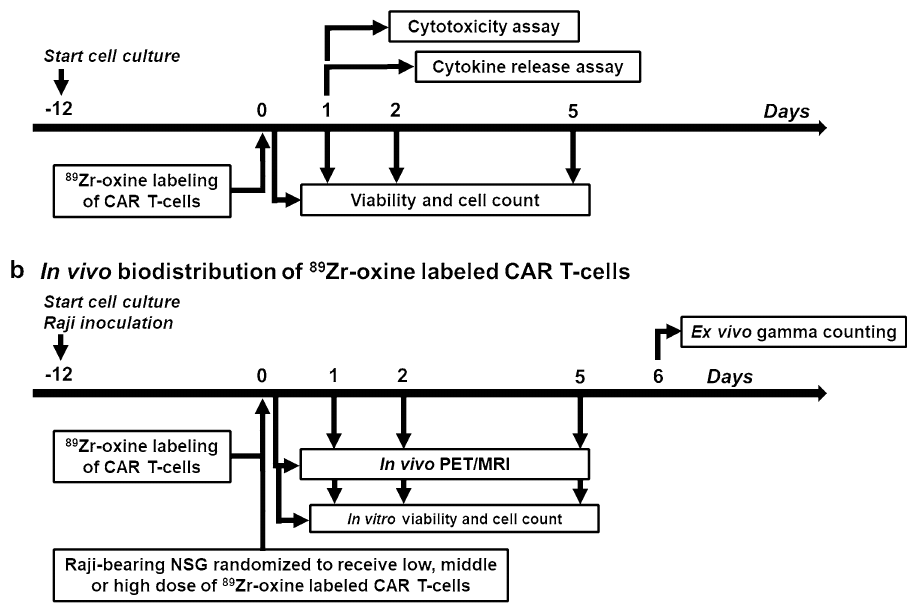
Figure 1. Study timelines. ( a ) In vitro measurements of cell health and function of 89 Zr labeled and unlabeled non-transduced (mock) T-cells and CAR T-cells were obtained in a separate experimental trial. Percent lysis of target Raji cells (cytotoxicity) and released cytokine levels in situ by the effector 89 Zr-oxine labeled and unlabeled mock and CAR T-cells were measured 24 h after incubation of the effector cells with the target cells. Incubation of effector and target cells began 3 h post 89 Zr-oxine labeling. Aliquots of 89 Zr-oxine labeled and unlabeled mock and CAR T-cells were subcultured for in vitro viability and live cell number counts on the same in vivo scan timepoints. ( b ) In vivo biodistribution measurement of 89 Zr-oxine labeled CAR T-cells began with CAR T-cell preparation and inoculation of NSG mice with Raji cells 12 days prior 89 Zr-oxine labeling and IV administration. NSG mice were randomized to receive either a low (126.7 ± 2.5 kBq, 1.87 ± 0.04 × 10 6 cells, n = 3 mice), middle (542.6 ± 92.1 kBq, 7.14 ± 0.45 × 10 6 cells, n = 5 mice), or high (1491.7 ± 36.1 kBq, 16.83 ± 0.41 × 10 6 cells, n = 3 mice) dose of 89 Zr-oxine labeled huLym-1-BB3z-CAR T-cells and underwent PET/MRI scans on day 0, 1, 2, and 5 time points, which corresponded to 3, 24, 48, and 120 h after CAR T-cell injection. Activity concentrations were obtained from PET scans and expressed as percent injected dose per gram of tissue of manually defined regions of interests that were identified on T1-weighted MRI anatomical scans. Coplanar PET and MRI scans were acquired simultaneously and were registered to the same space. Invasive ex vivo biodistribution was performed on day 6 post injection to complement the in vivo PET imaging study arm. 89 Zr-oxine labeled and unlabeled CAR T-cells were subcultured for in vitro viability and live cell number counts on the same scan